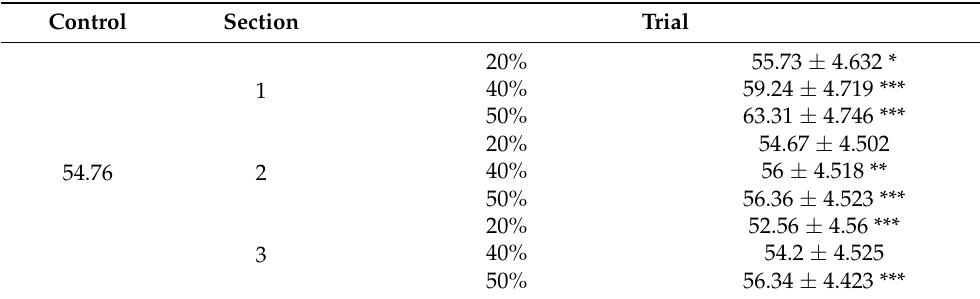
Table 3. Statistical significance test results of texture analysis for average by all Sections and degrees of obstruction against flow control conditions.